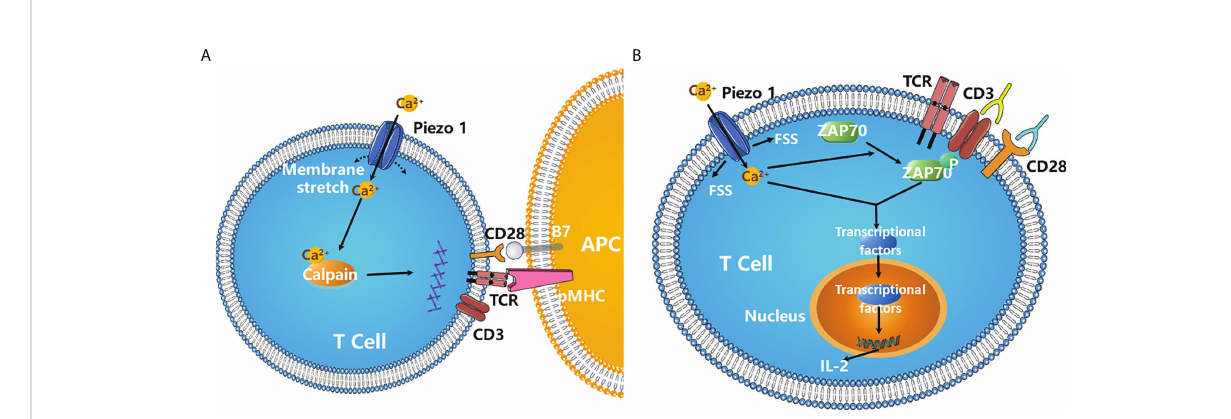
FIGURE 4 Piezo1 is required for the optimal T cell activation. (A) During immune synapse formation, membrane stretch triggers Piezo1 opening and Ca 2+ in fl ux, which results in the activation of calpain. Activated calpain then reorganizes cortical actin scaffold, thereby favoring the optimal human T cell activation (68). (B) Fluid shear stress (FSS) in combination with soluble and/or bead-bound CD3/CD28 Abs signi fi cantly enhanced the activation of T cells and ZAP70 phosphorylation, which requires the activation of Piezo1 channels and Ca 2+ in fl ux. FSS also activates three major transcription factor NFAT, NF- k B and AP-1, increasing the expression of cytokines such as IL-2 (69).